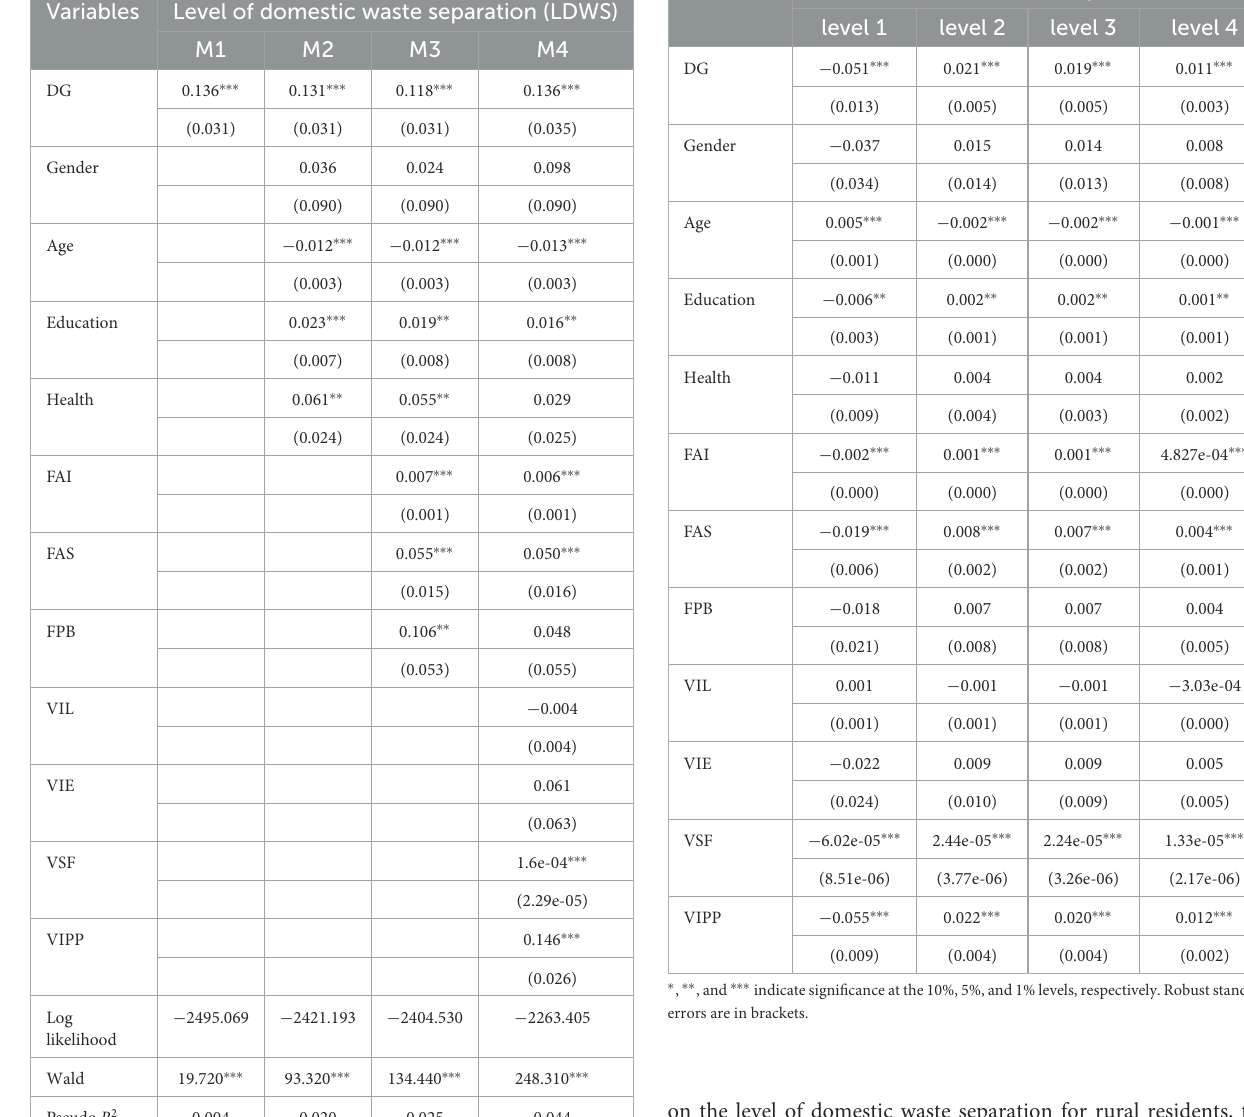
TABLE 3 Regression results on the direct impact of digital governance on the level of domestic waste separation for rural residents. Variables